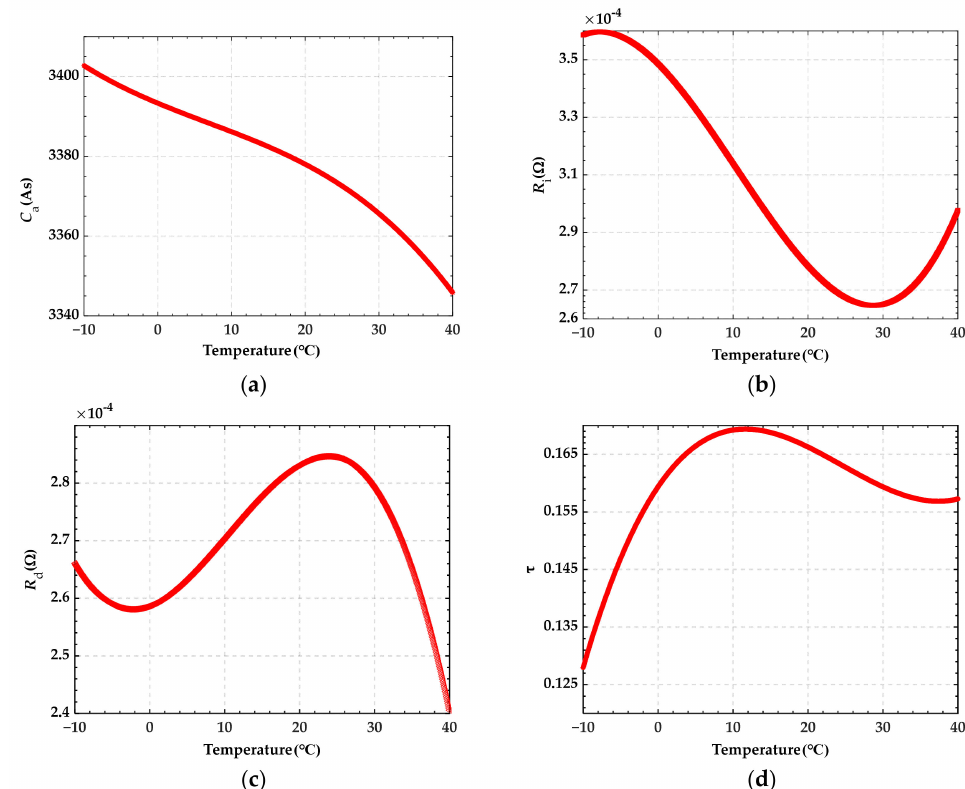
Figure 3. The change of capacitance and parameters at different temperatures: ( a ) Capacitance-T fitting curve; ( b ) Ohmic internal resistance-T fitting curve; ( c ) Polarization resistance-T fitting curve; ( d ) Time constant-T fitting curve.